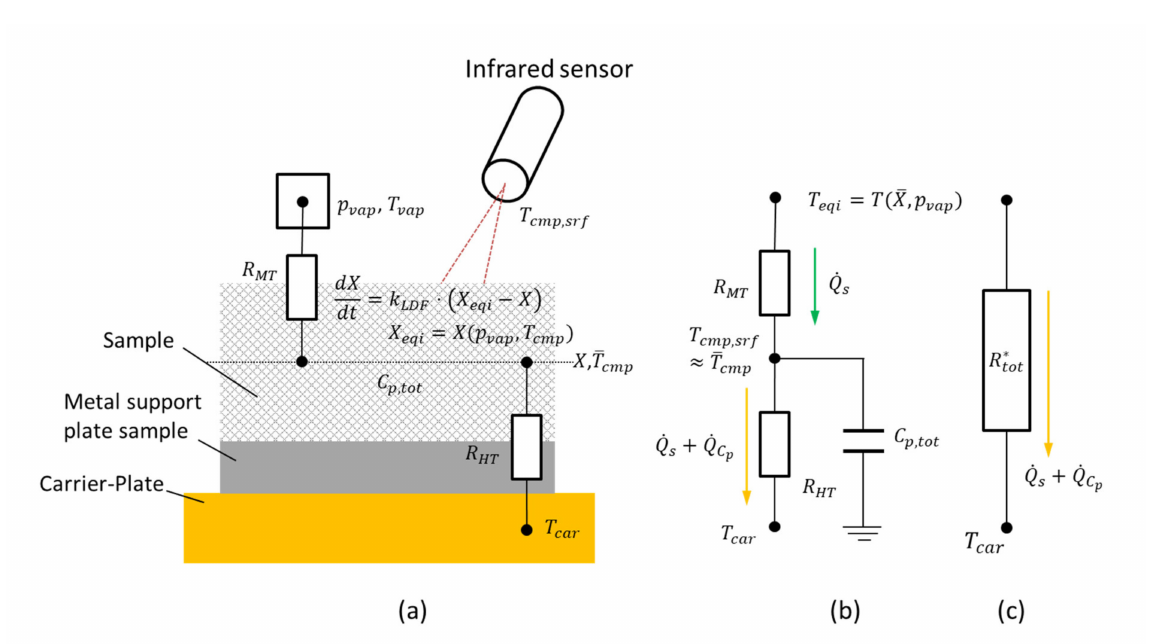
Figure 3. Coupled heat and mass transfer linear driving force (LDF) model of an adsorbent–metal composite ( a ). The surface temperature is measured with an infrared sensor; this is (approximately) the temperature of the composite T cmp . Model reduction to resistance–capacitance model ( b ) by using driving temperature equivalents for the mass transfer equation. Further model reduction to a single resistance/impedance model ( c